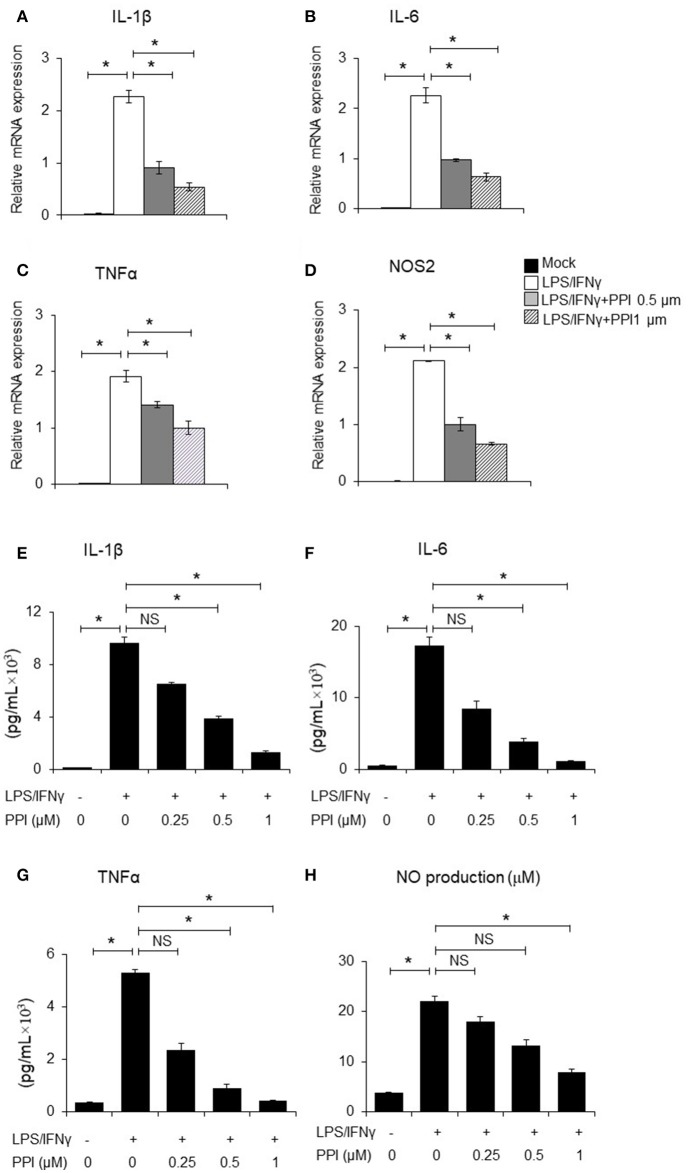
PPI ameliorated the inflammatory cytokines production of BMMs stimulated by LPS/IFN-γ. (A–D) IL-1β, IL-6, TNF-α, and NOS2 mRNA expression of BMMs stimulated with LPS (1 μg/ml) /IFN-γ (100 ng/ml) for 6 h in the presence of PPI (0, 0.5, or 1 μM) pretreated for 3 h. Representative data of at least 3 mice. Data represent mean ± SEM. NS, P > 0.05, *P < 0.05, One-way analysis of variance (ANOVA). (E–H) ELISA in the supernatants of BMMs stimulated with LPS/ IFN-γ for 6 h (IL-1β, IL-6, and TNF-α) and 24 h (NO) in the presence of PPI (0.25, 0.5, or 1 μM) pretreated for 3 h. Data represents mean ± SEM of four pooled experiments. NS, P > 0.05, *P < 0.05, One-way ANOVA.